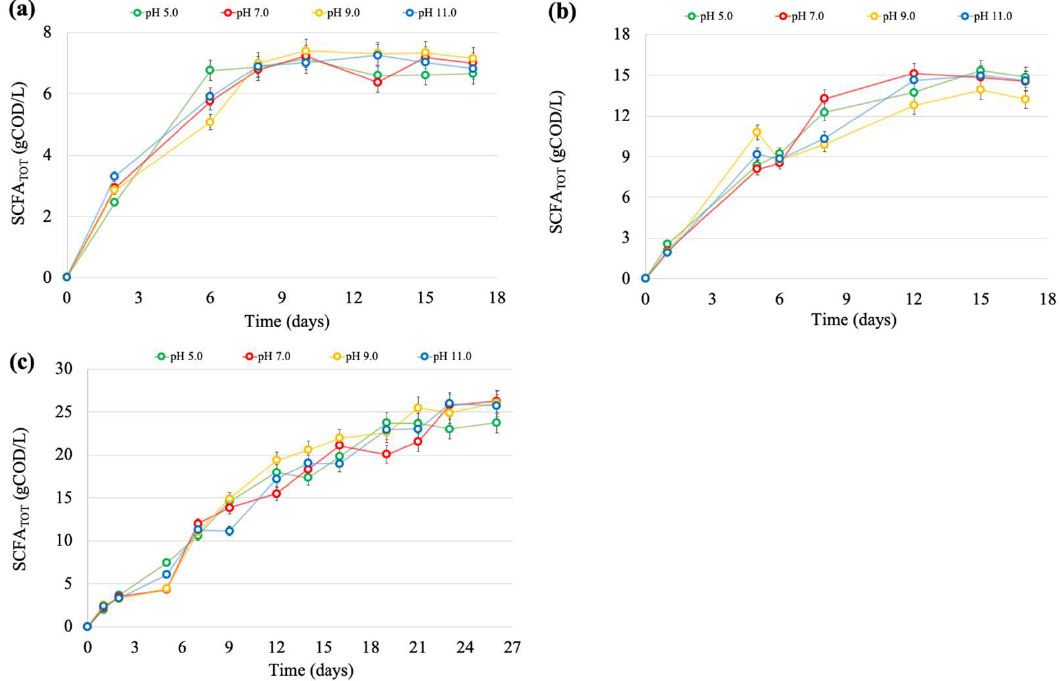
Figure 2. SCFA concentration trends (g COD/L) in the thermophilic batch test T8 ( a ); thermophilic batch test T12 ( b ); thermophilic batch test T8-P ( c ). All three series under the initial pH of 5.0, 7.0, 9.0, and 11.0.